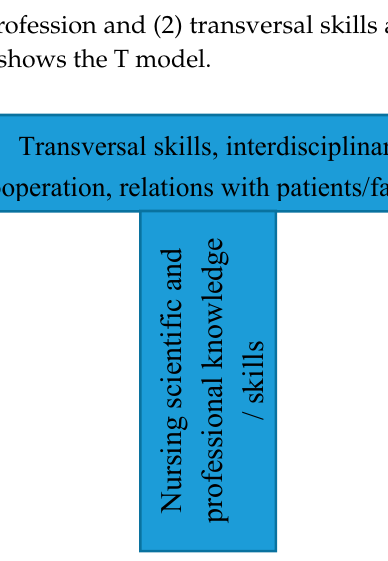
Figure 1. T model of the education in service profession.